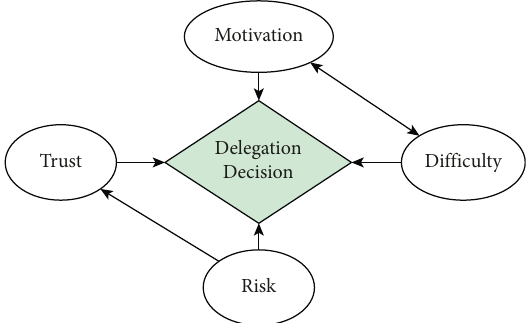
Figure 7: Data delegation